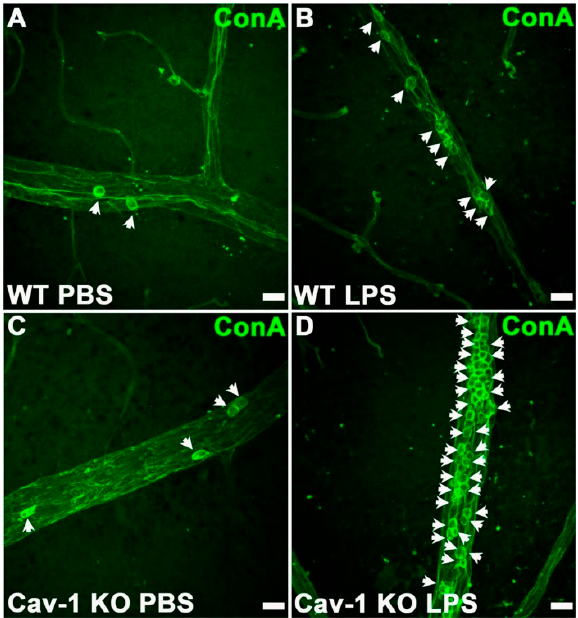
Figure 6. Caveolin-1 deficient mouse retinas show increased leukostasis when challenged with LPS. White arrows point to leukocytes. This figure is reproduced from Li et al. [139] with permission from the Association for Research in Vision and